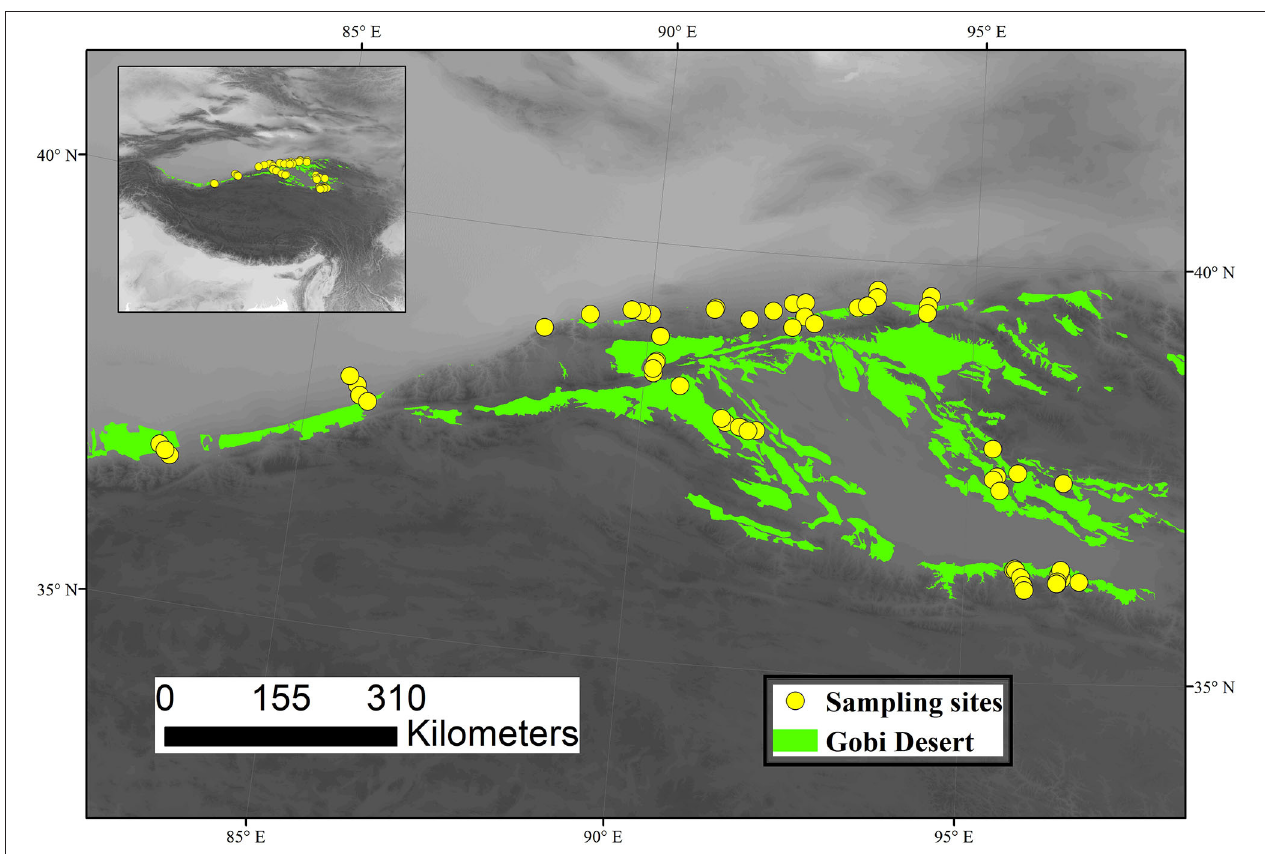
FIGURE 1 | Distribution of sampling sites in Gobi deserts of northern Qinghai–Tibet Plateau.